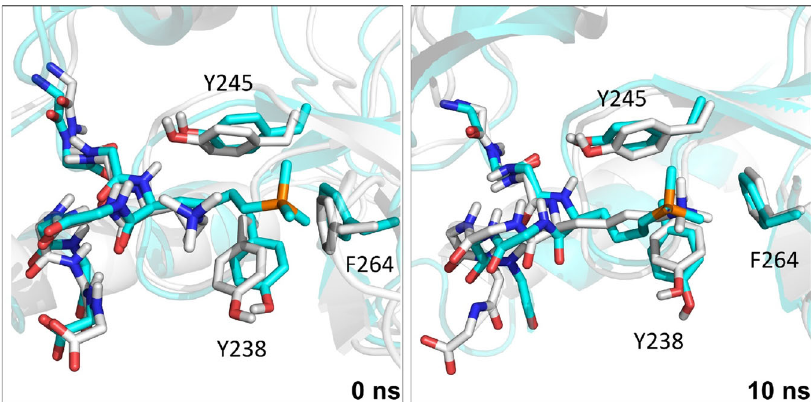
Fig. 3 MD simulation studies for reader SGF29 TTD . Snapshots of simulations for SGF29 TTD complexed with a histone H3 fragment (liquorice) containing K P 4me 3 (cyan) or K4me 3 (white) at 0 ns and 10 ns.